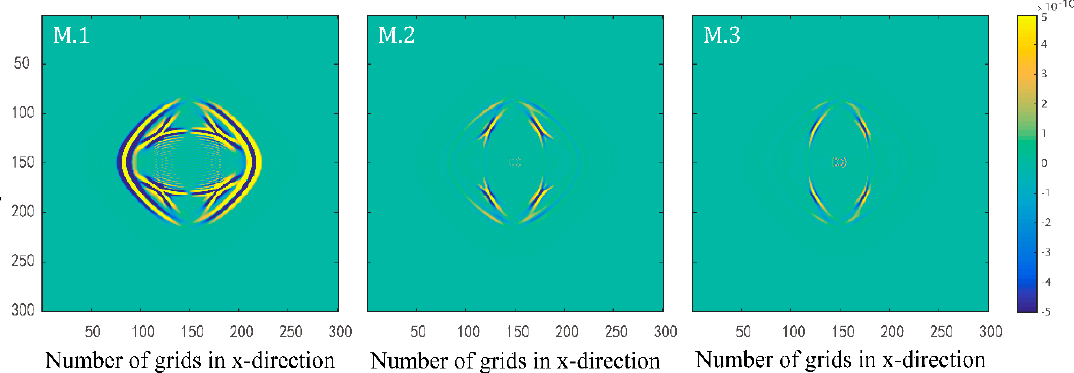
Figure 1. Snapshots of solid–phase x–direction velocity components with three different fluid viscosity coefficients at t = 0.15 s.